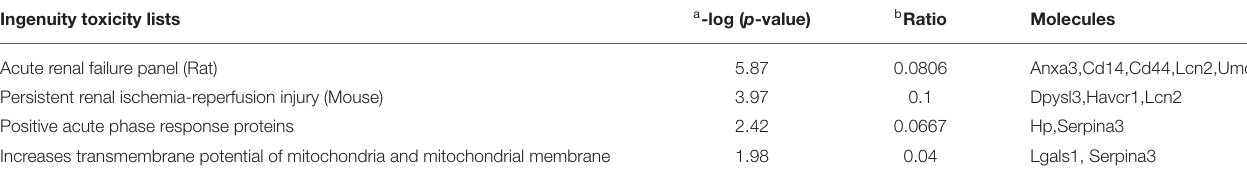
TABLE 2 | Toxicity analysis of proteins and metabolites, which showed over 2-fold differences between the Crystal group and Control group. Ingenuity toxicity